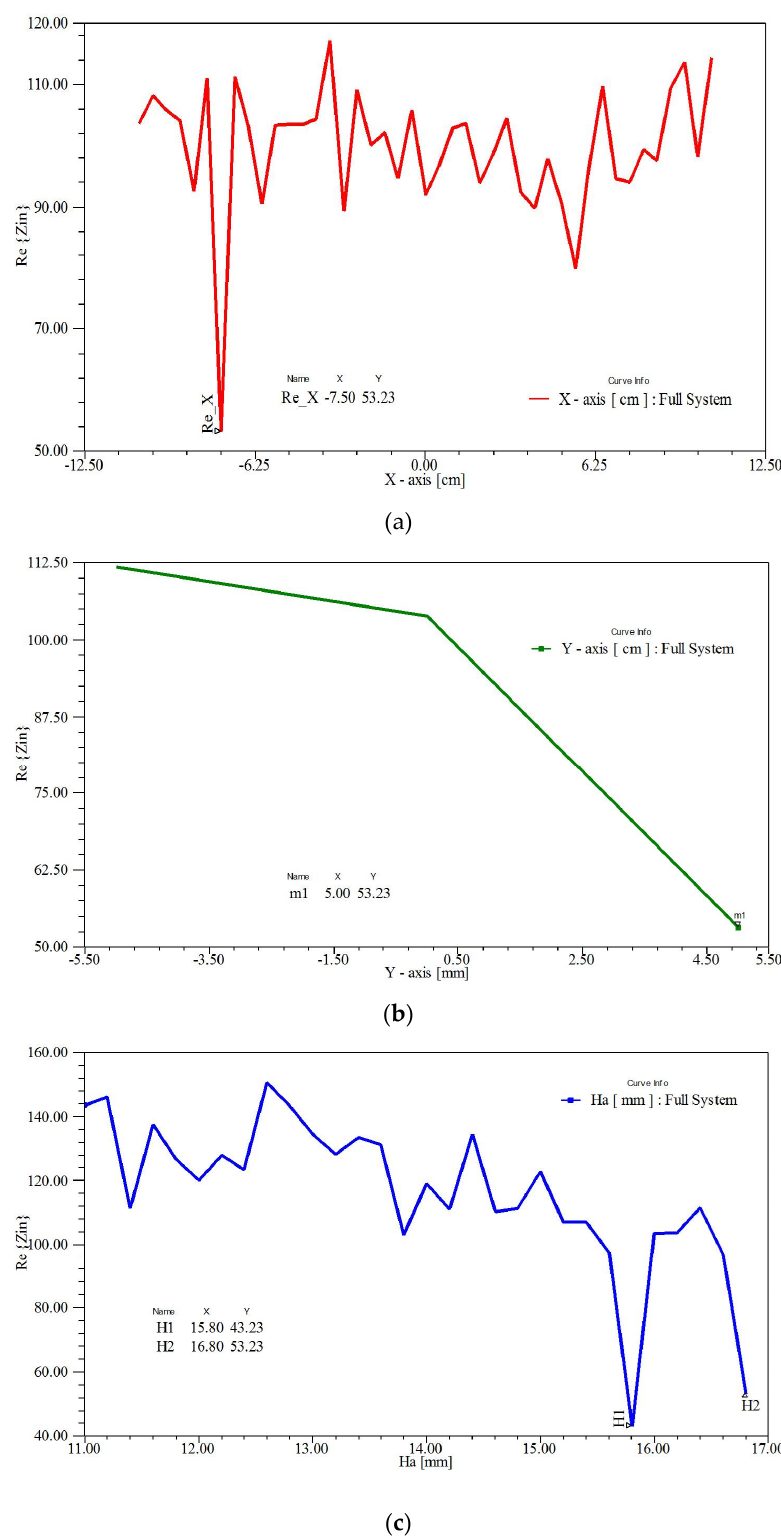
Figure 22. Input impedance real part of proposed full satellite at 2450 MHz: Proposed antenna + 3U CubeSat: ( a ) Input impedance real part at 2450 MHz versus X-axis (cm); ( b ) Input impedance real part at 2450 MHz versus Y-axis (cm); ( c ) Input impedance real part at 2450 MHz versus Z-axis (mm): Ha (mm).